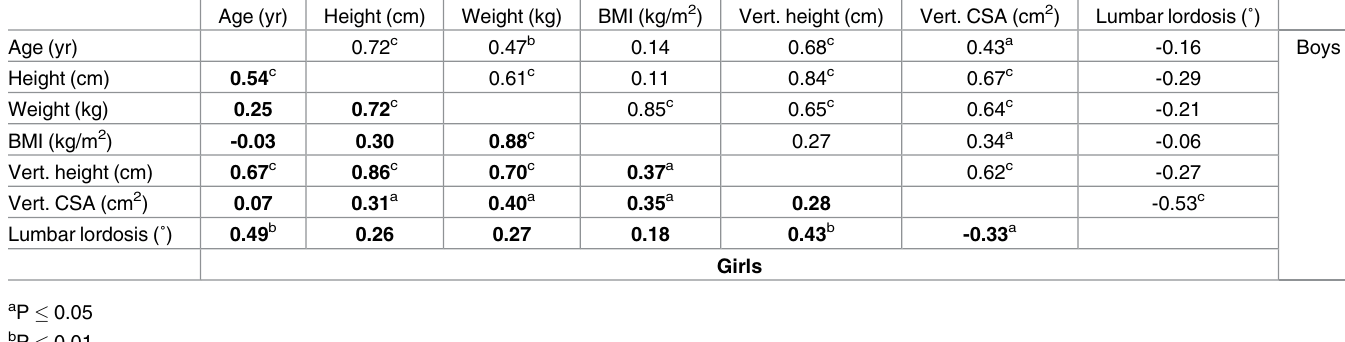
Table 2. Correlation matrix of age, anthropometric characteristics, and MRI measuresof vertebralmorphology and degree of lumbar lordosis in 40 healthy adolescent boys and 40 adolescent girls.